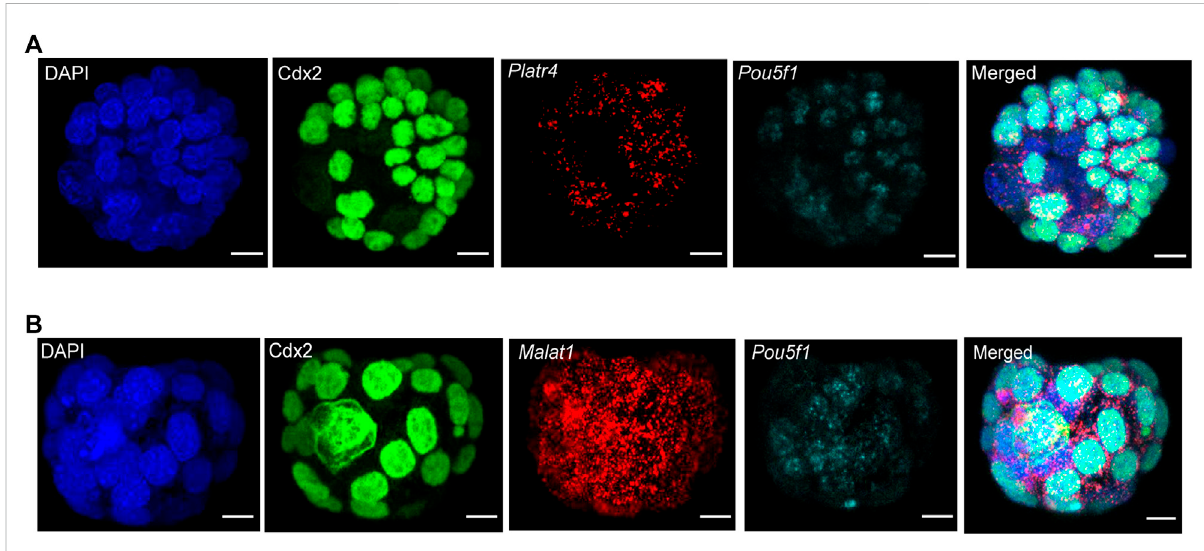
FIGURE 4 (A) Detection of multiple RNA transcripts, such as lncRNA Platr4 , mRNA Pou5f1, and Cdx2 protein in 3D-mouse blastocysts. Nuclei were counterstained with DAPI. The green color represents the Cdx2 protein signal, and red and cyan punctate dots represent the RNA signal for Platr4 and Pou5f1 transcripts. All images are shown at the maximum intensity, the Z-projection, scale bars: 12 μ m. (B) Detection of Malat1 lncRNA, Pou5f1 mRNA, and Cdx2 protein in 3D-mouse blastocysts. Nuclei were counterstained with DAPI. The green color represents the Cdx2 protein signal, and red and cyan punctate dots represent the RNA signal for Malat1 and Pou5f1 transcripts. All images are shown at the maximum intensity, the Z-projection, scale bars: 12 μ